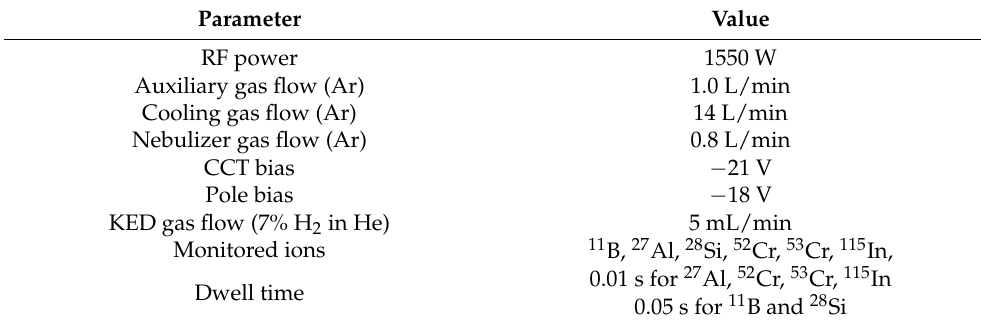
Table 2. ICP-MS measurement parameters for online-LASIL.